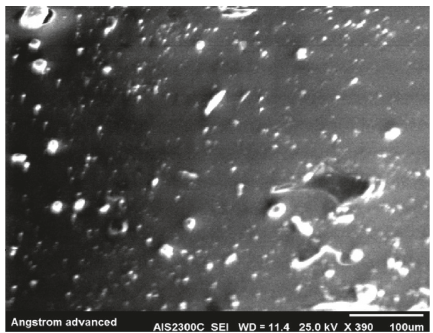
Figure 2: 3% by weight polyester powder group.